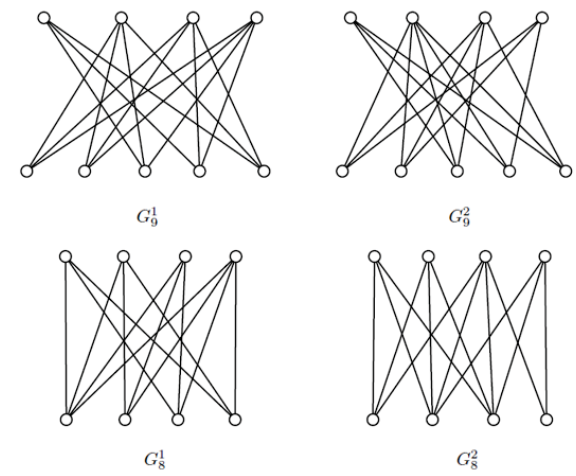
Figure 2: Graphs used in the proof of Claim 6.